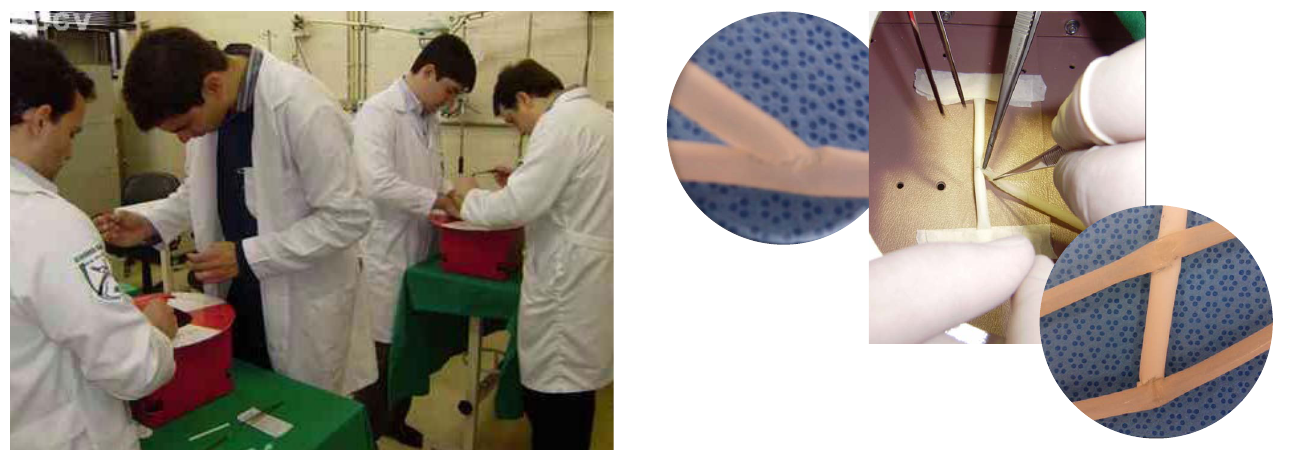
Fig. 3 - Anastomoses confection with silicone tubes: a- end-to- side anastomosis; b- sequential anastomosis.